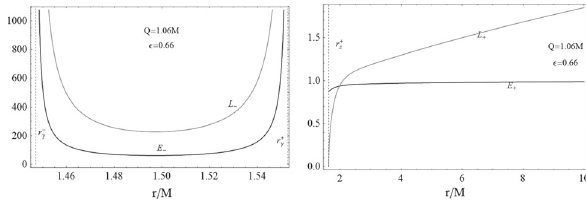
√ √ Fig. 21 Class : ( 3 6 / 7 ) M ≤ Q ≤ 9 / 8 M and (cid:9)(cid:9) (cid:2) + ≤ (cid:2) < M / Q . choice is as follows: Q = 1 . 06 M and (cid:2) = 0 . 66. Then (cid:9)(cid:9) (cid:2) + = 0 . 618133, M / Q = 0 . 943396 r + s = 1 . 62572 M , r − γ = 1 . 44708 , M , and r + γ = √ √ 1 . 55292 M .Circularorbitsexistwithangularmomentum L = L + ( gray Fig. 22 Class : ( 3 6 / 7 ) M ≤ Q ≤ 9 / 8 M and M / Q ≤ (cid:2) < 1. curve ) and energy E = E + ( black curve ) in r − γ < r < r + γ ( left plot ) Parameter choice is as follows: Q = 1 . 06 M and (cid:2) = 0 . 96. Then and L = L − in r > r + s ; L = 0 at r = r + s ( right plot ) M / Q = 0 . 943396, r − γ = 1 . 44708 , M and r + γ = 1 . 55292 M . Circular orbits exist with angular momentum L = L + ( gray curve ) and energy E = E + ( black curve ) in r − γ < r < r +